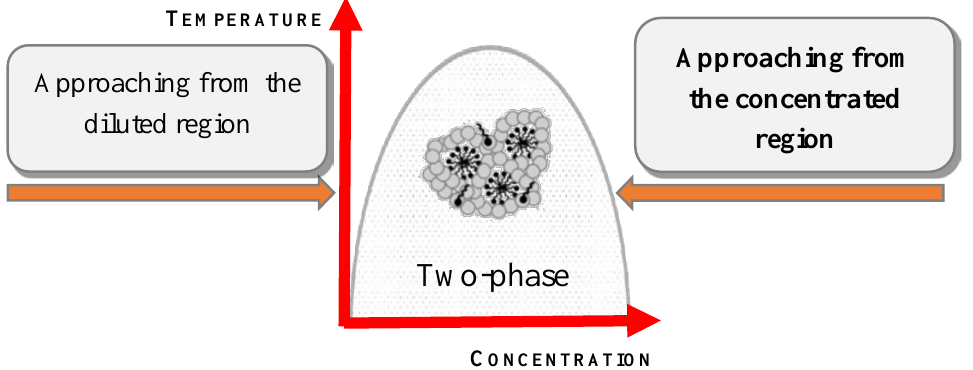
Figure 9. Two di ff erent approaches for studying the behavior and deposition of polyelectrolyte- Figure 9. Two different approaches for studying the behavior and deposition of polyelectrolyte– surfactant mixtures onto solid surfactant mixtures onto solid surfaces.